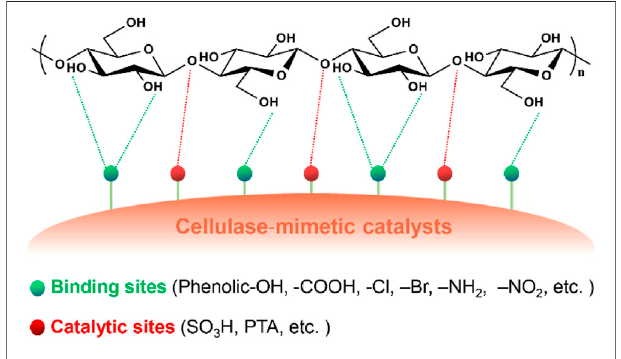
FIGURE3| Asummaryoffunctionalgroupsasbindingsitesofcellulase- mimetic solid acid catalysts and the proposed catalysis mechanism for cellulose hydrolysis.